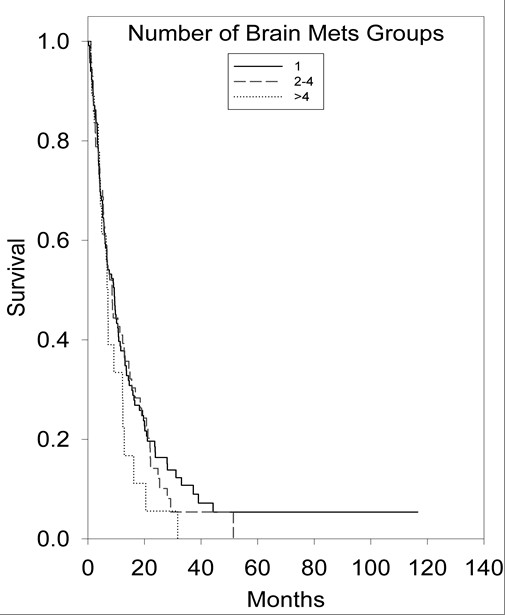
Kaplan-Meier survival curve illustrating overall survival based on number of brain metastases.